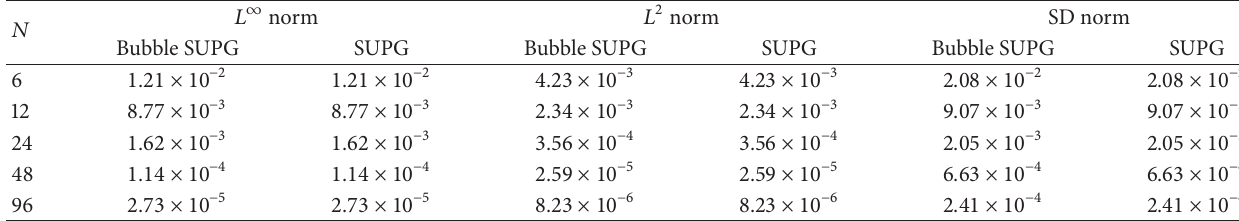
Table 15: 𝜀 = 10 −2 , Problem 4 (comparison of error).